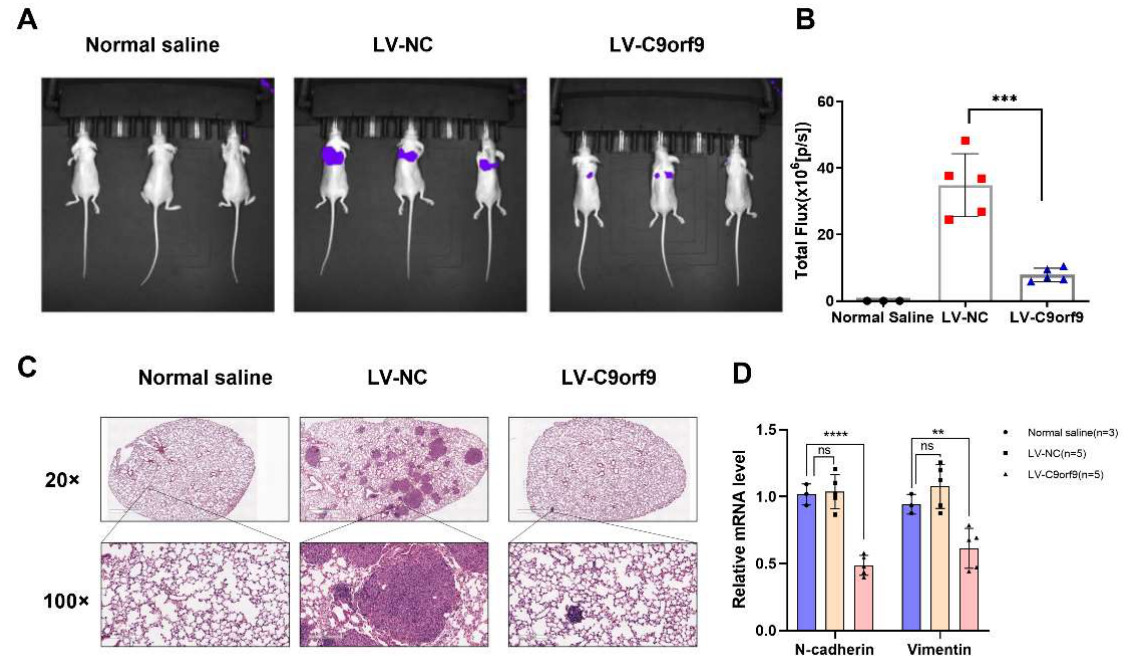
Figure 5. C9orf9 inhibits tumor metastasis in vivo. ( A ). Representative images of luciferase expres- sion from lung metastasis of the normal saline ( n = 3), LV-NC ( n = 5), and LV-C9orf9 ( n = 5) groups. ( B ). Quantification of the total flux, compared with the LV-NC group. ( C ). HE staining of lungs from the normal saline, LV-NC, and LV-C9orf9 groups. ( D ). mRNA level of metastasis-related marker N- cadherin and Vimentin. ** p < 0.01, *** p < 0.001, **** p < 0.0001.